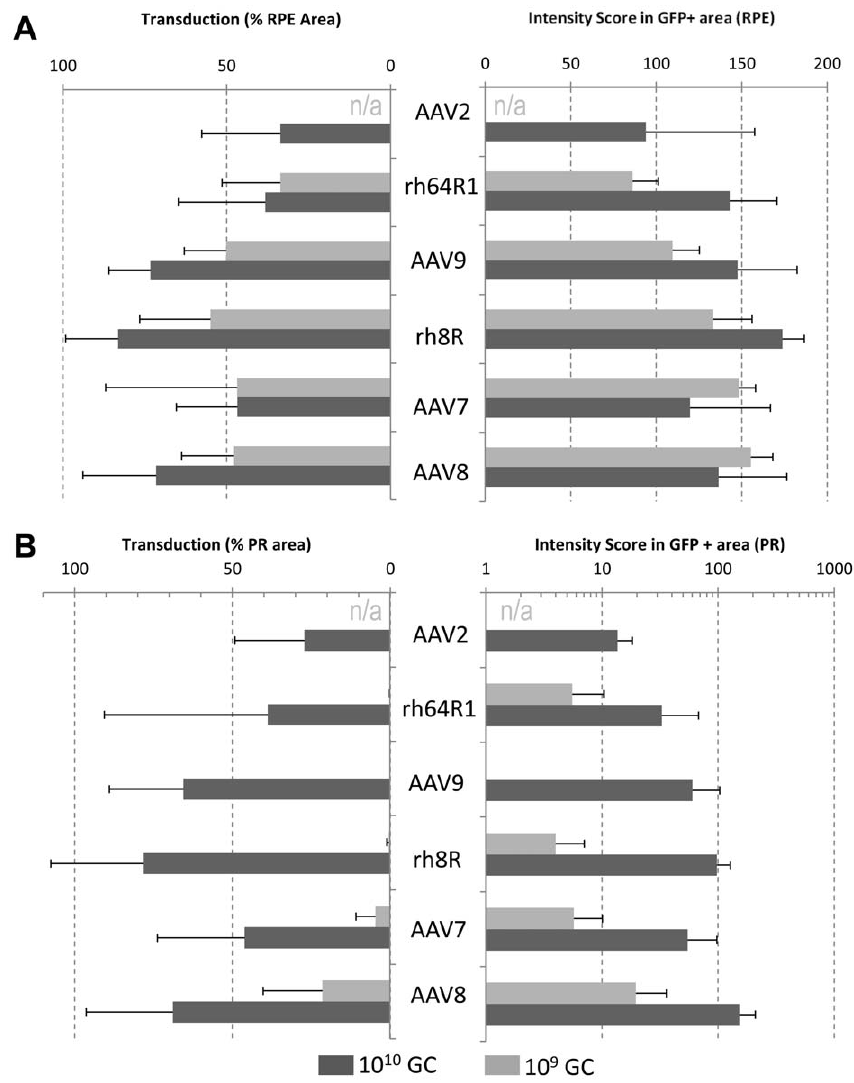
Figure 1. Quantitative analysis of tropism and transgene expression levels in the NHP eye. Cynomolgus macaques were injected with AAVs expressing 10 9 or 10 10 GC per eye. Following necropsy at 4–5 month post injection, retinas were sectioned and analyzed for direct fluorescence. Data from a morphometric analysis in the RPE (A) and PR (B) layers is presented with the relative area of transduction on the left and an intensity scoring on the right. AAV2 and AAV8 data are historical data from an analogous, previously reported study [6] [a 10 9 GC injection was not performed for AAV2 (n/a)]. Eyes for which the injection failed as noted in Table 1 were excluded from this analysis. Data is presented as average and standard